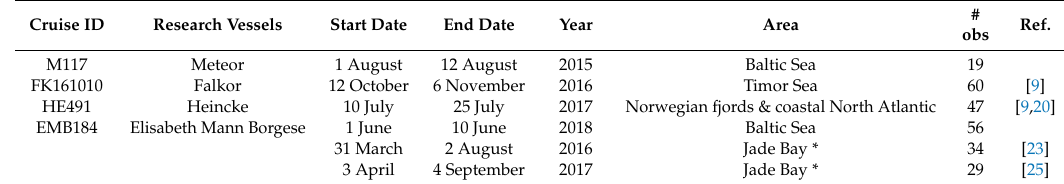
Table 1. Cruise names, research vessels, dates, areas of observation, number of quality-controlled gas transfer observations, and studies that have discussed the cruises in more